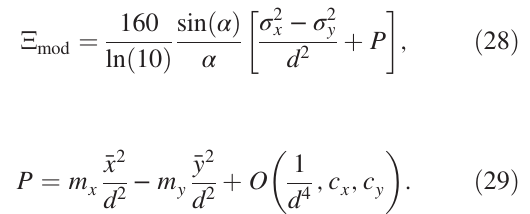
FIG. 3. Normalized quadrupole moment ( σ 2 x − σ 2 y )/ d 2 as a function of the beam position; σ x =d ¼ 0 . 15 , σ y =d ¼ 0 . 075 , α ¼ 45 °, c c 0 . 1885 : (a) as a function of ¯ x=d , x ¼ y ¼ ¯ y=d ¼ 0 . 05 ; (b) as a function of ¯ y=d , ¯ x=d ¼ 0 . 05 .